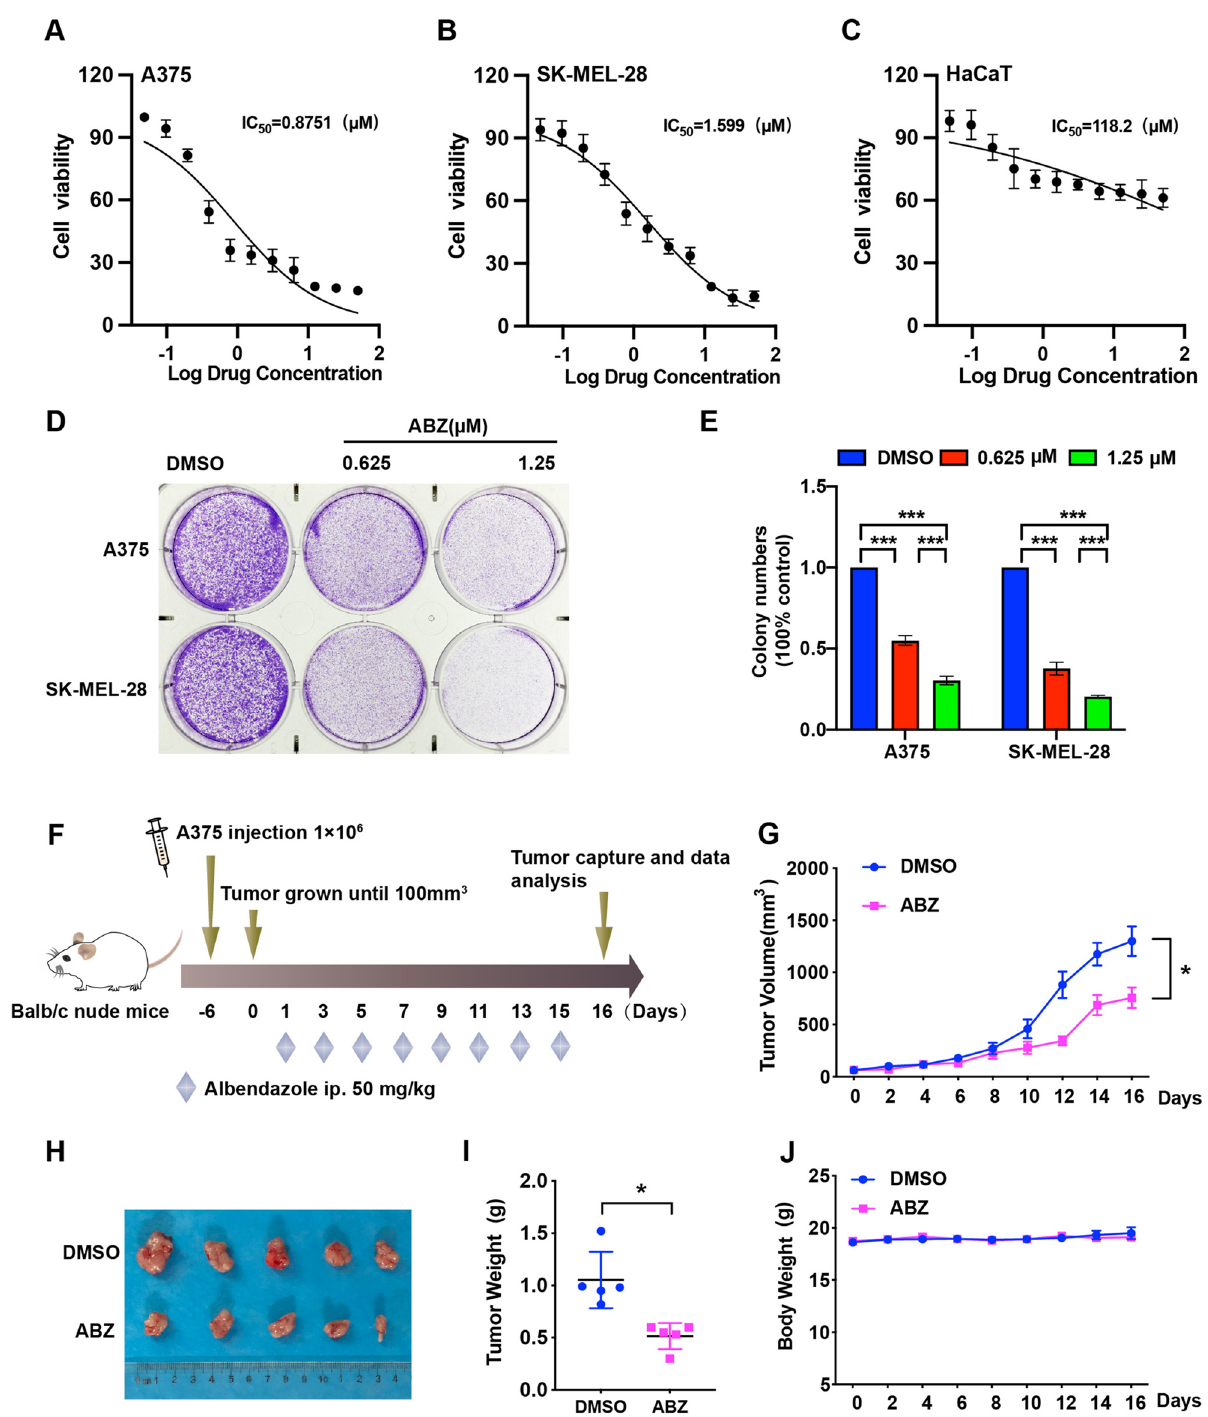
Figure 1. ABZ inhibited melanoma cell growth in vitro and in vivo. A375 ( A ), SK-MEL-28 ( B ) and HaCaT ( C ) cells were treated with various doses of ABZ for 2 days, and MTT assays were performed to determine cell viability. These data were subsequently used to calculate IC50 values. ( D ) Colony growth of A375 and SK-MEL-28 cells treated with the indicated concentrations of ABZ in 6-well plates. ( E ) The number of colonies that formed from A375 and SK-MEL-28 cells was evaluated 14 days after treatment with the indicated concentrations of ABZ. The results are presented as the mean ± SD of three independent experiments, *** p < 0.001. ( F ) A375 cells were injected into mice (n = 5 mice per group) on Day -6, and 50 mg/kg ABZ was administered as indicated. ( G ) Tumor volume was measured at the indicated time points. Data represent mean ± SD, * p < 0.05. ( H ) Representative images of tumors after ABZ treatment at the end of the experiment in the mouse model. ( I ) Tumor weight was measured on Day 16. Data represent mean ± SD, * p < 0.05. ( J ) Mouse weight was measured at the indicated time